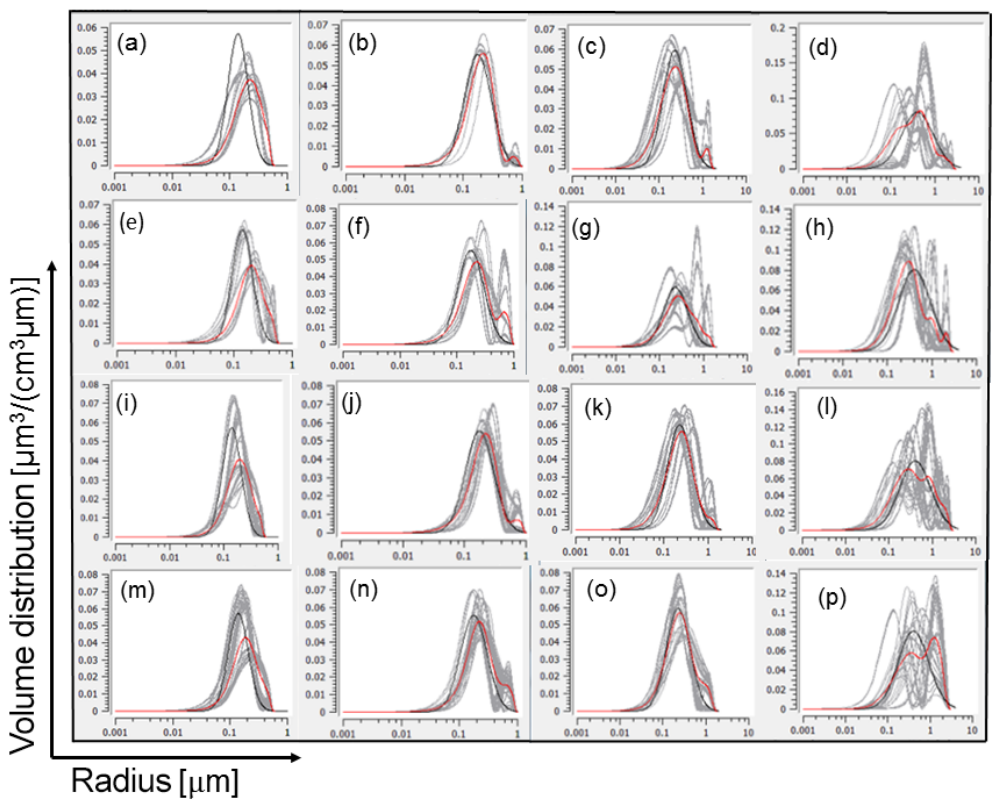
Figure 4. Examples of PSDs for input data with 15% noise: the rows correspond to different imaginary parts of the CRI: 0, 0.005, 0.01, and 0.05. The columns correspond to gsd: 1.5, 1.7, 1.9, 2.3. The real part of CRI is 1.5. The mean PSD, i.e. the solution, is shown as a solid red